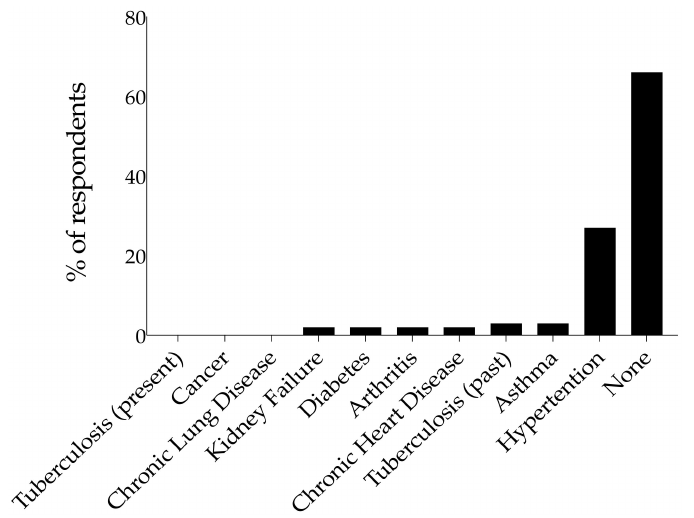
Figure 3. Prevalence of comorbidities reported ( n = 62). Bars show the percentage of respondents that reported the respective comorbid